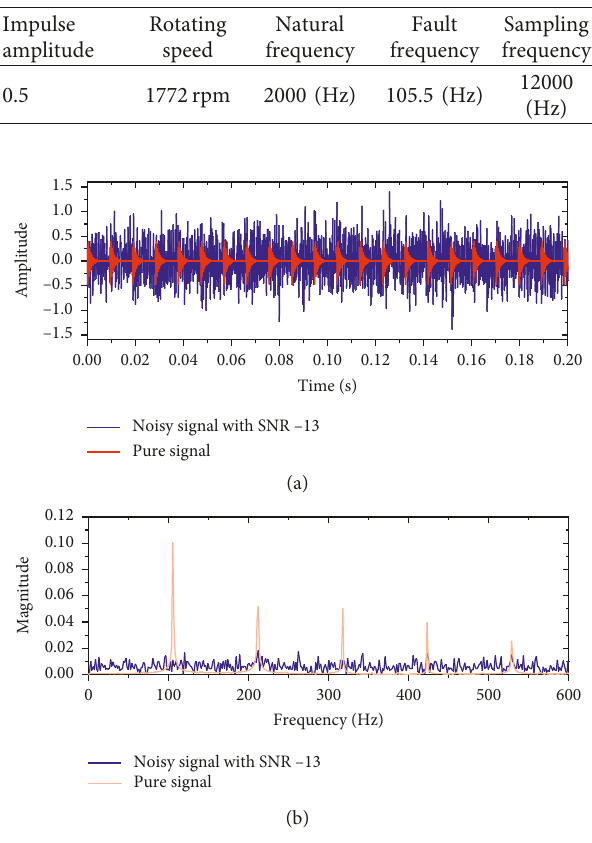
Figure 5: Simulated vibration signals of outer race fault with and without noise signal and their envelope spectrums. (a) Waveforms of the both signals. (b) Envelope spectrum of the two